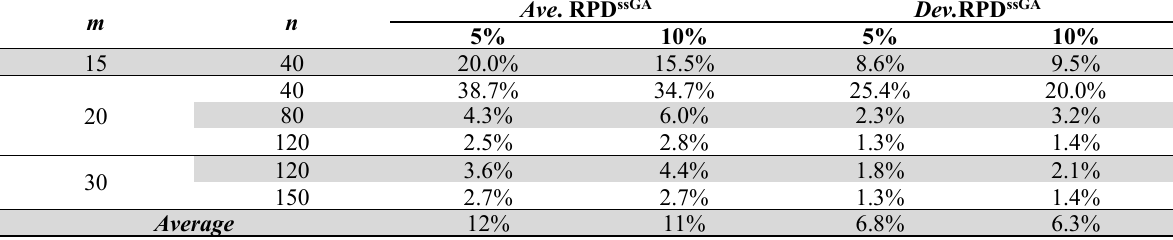
Results for PFS with missing operation solved by